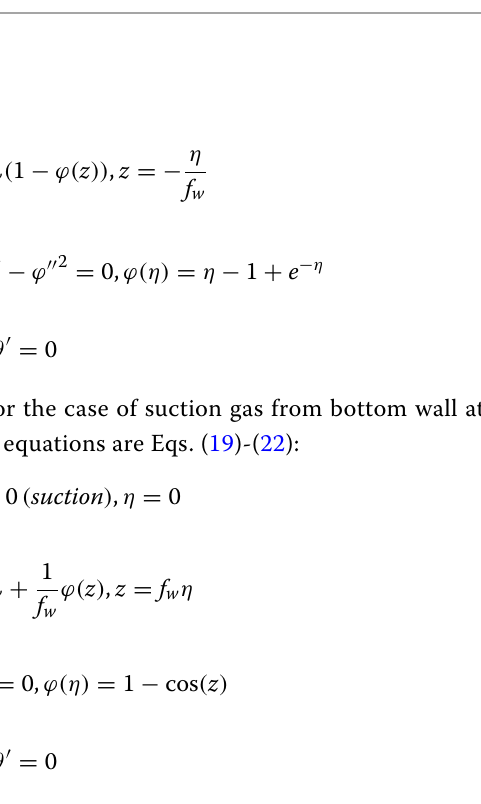
Fig. 2 Theoretical dimensionless Hiemenz flow solution, see Eqs. (18), (20), (21) and